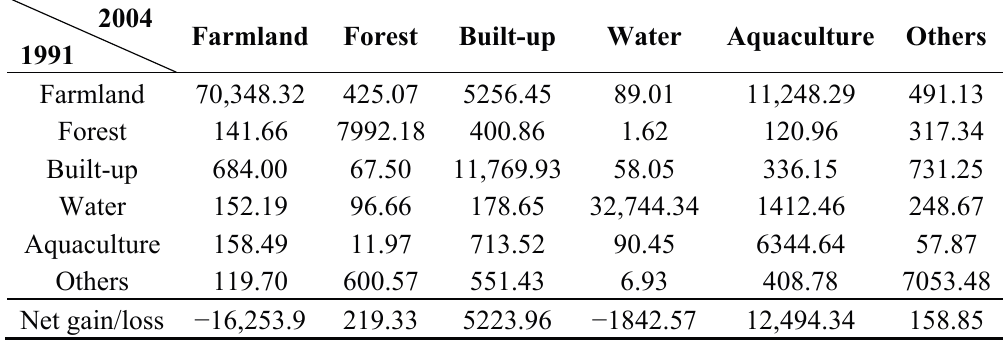
Figure 6. Dynamic degree index of land cover change. Table 2. Land use transition matrix between 1991 and 2004 in the study area (unit: hectares).